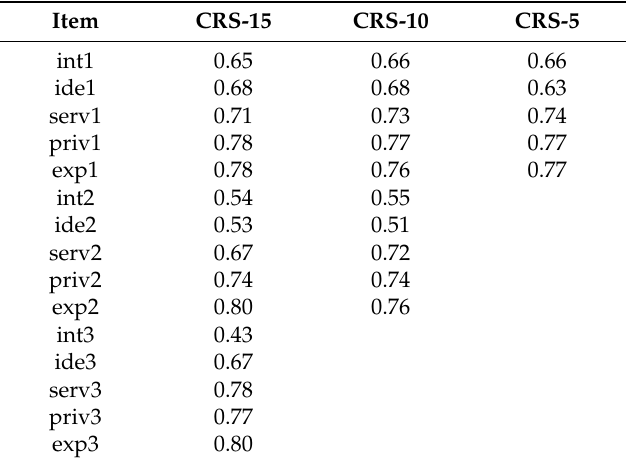
Table 4. EFA extracted loadings for CRS subscale items.